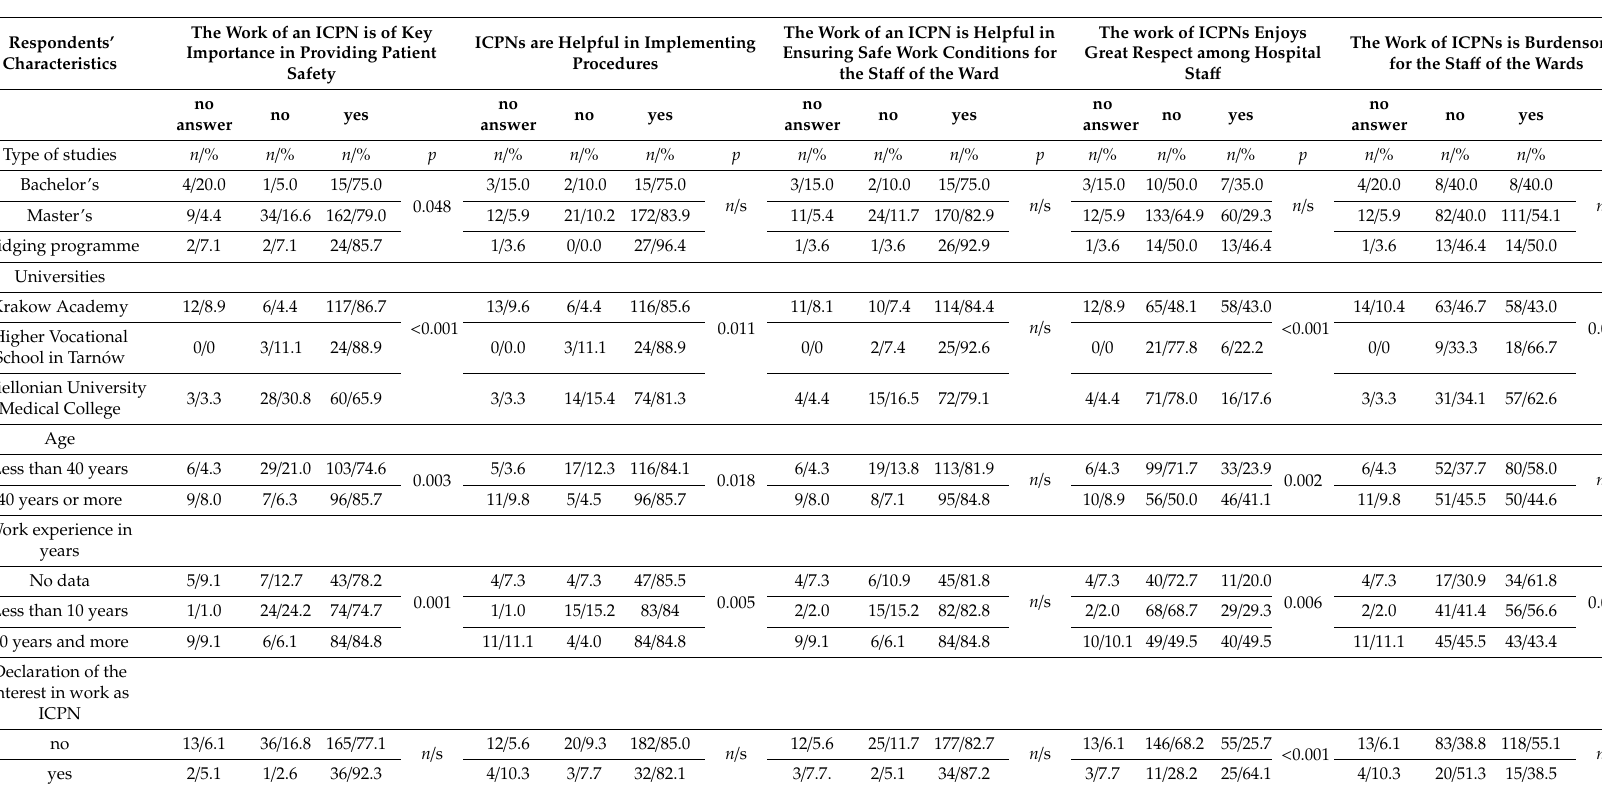
Table 3. Respondents’ opinion on the role of infection prevention and control nurse depending on type of studies, age, work experience, and declaration of the interest in work at this